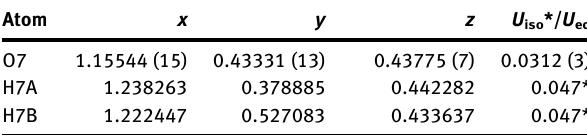
Table  : Fractional atomic coordinates and isotropic or equivalent isotropic displacement parameters (Å 